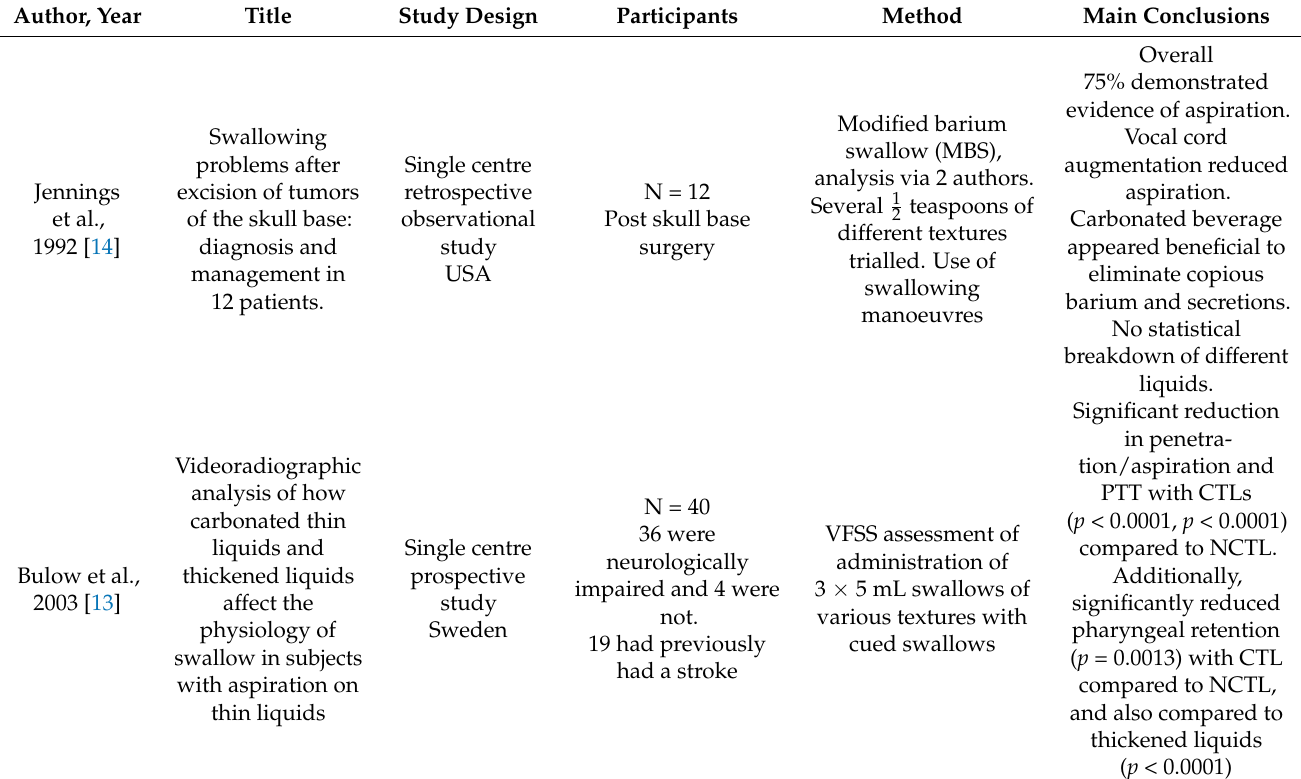
Table 1. Summary of articles included for